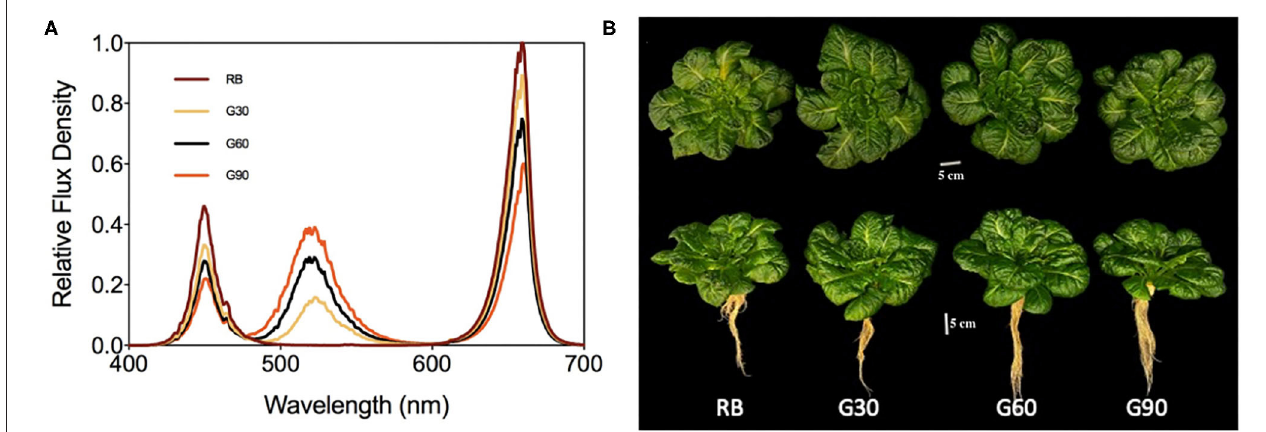
FIGURE 1 | The spectral distribution of different treatments (A) and photograph of lettuce grown under treatments (B) .